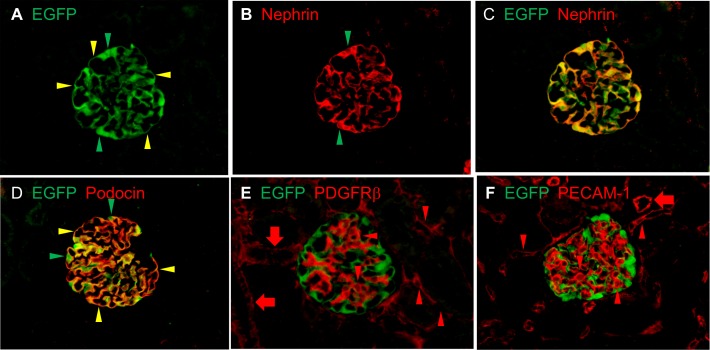
Protein expression of EGFP and glomerular cell markers in Nephrin-EGFP mice.(A-C) EGFP and nephrin were co-expressed along glomerular capillaries (yellow arrowheads). Cell bodies of podocytes located at the outer surface of glomerular capillaries (green arrowheads) also expressed EGFP (A) but nephrin expression was spared (B). (D) Similarly, EGFP and podocin were expressed along glomerular capillaries (yellow arrowheads). Podocyte cell bodies expressed EGFP but not podocin (green arrowheads). (E) PDGFRβ was expressed at glomerular and peritubular capillaries (arrowheads) and walls of arterioles (arrows), and did not co-localize with EGFP. (F) PECAM-1 was expressed along glomerular and peritubular capillaries (arrowheads) and inner surface of arterioles (arrow), and did not merge with EGFP. Magnification, 40x.